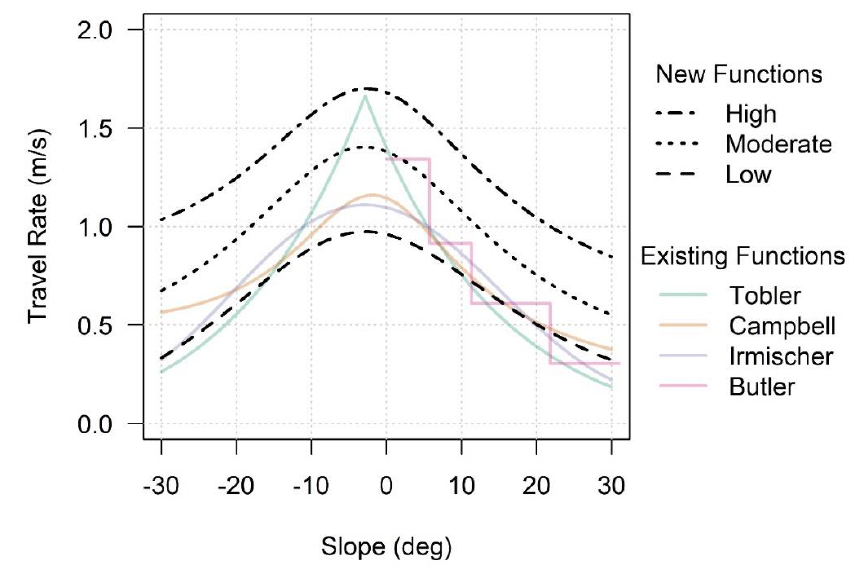
Figure 5. Firefighter travel rate functions (black lines) in comparison to four existing, relevant travel rate functions. The travel rate function shown form Campbell et al. [29] represents their 5th percentile function, which they demonstrated to be aligned with typical pedestrian hiking rates.